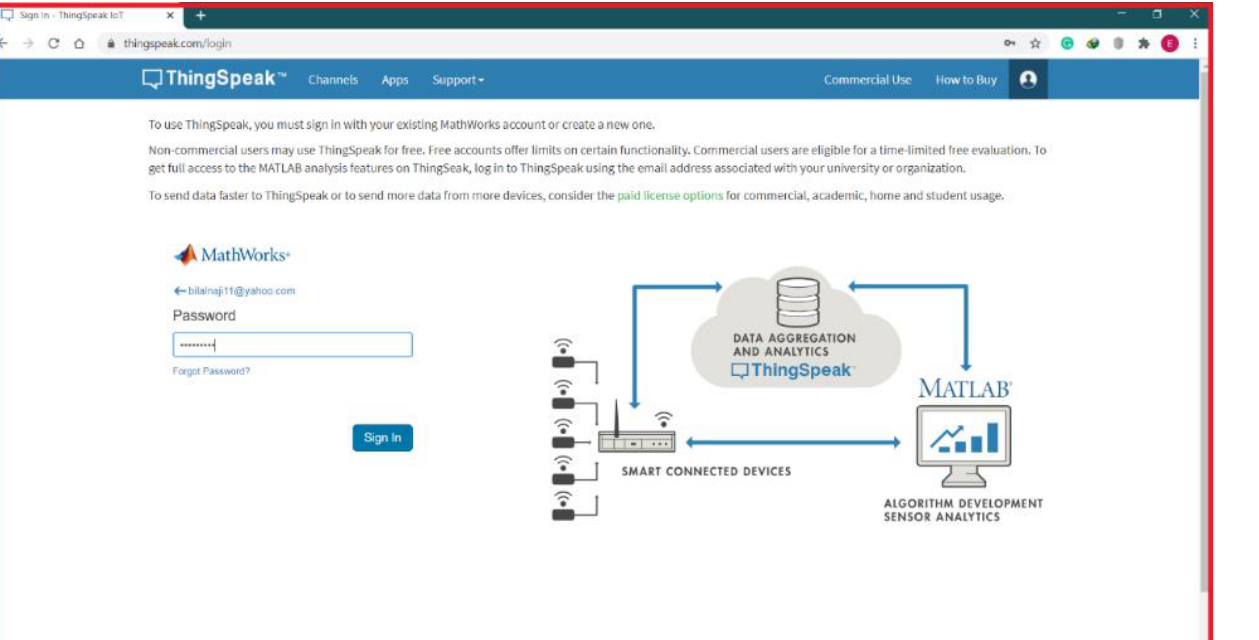
Figure 11. Thing-Speak platform.